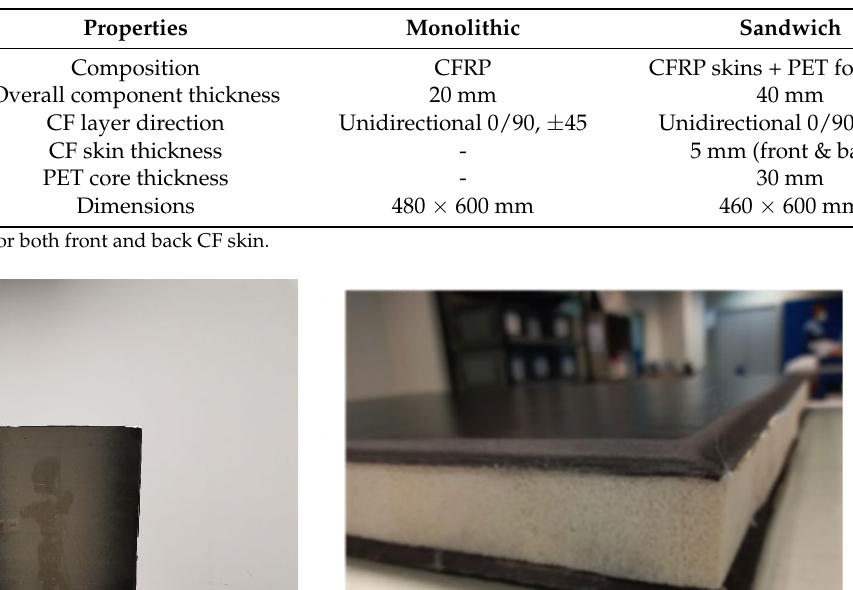
Table 2. Properties of the composite samples.